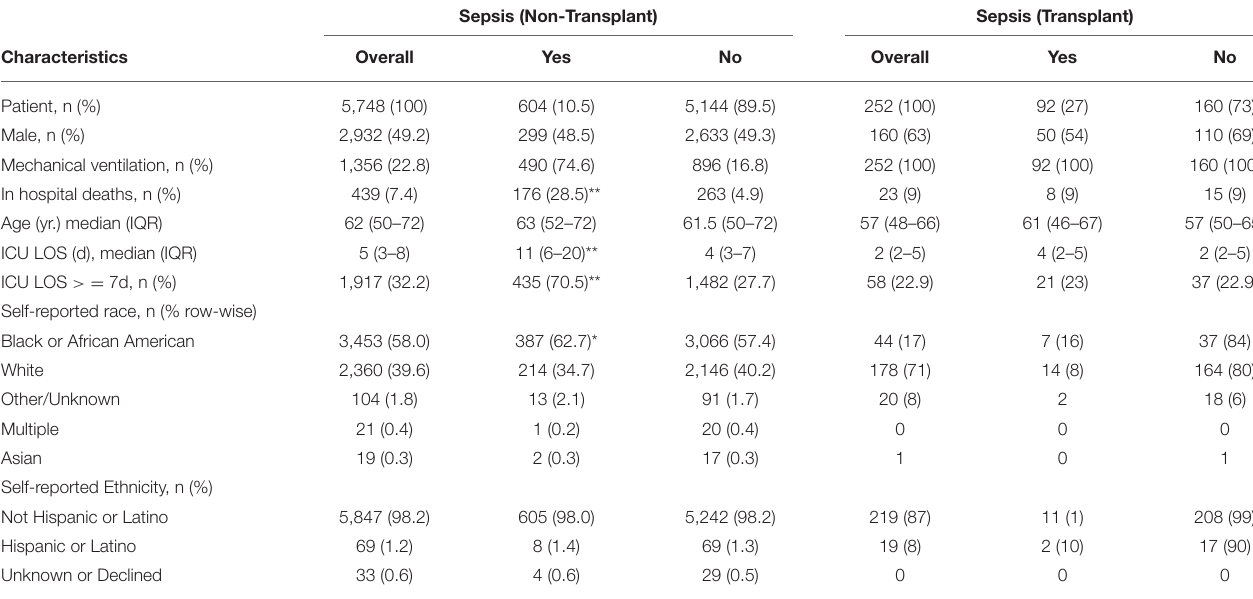
TABLE 1 | Characteristics of the study population. Sepsis (Non-Transplant) Sepsis